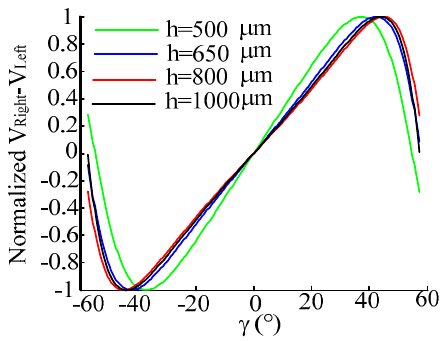
Figure 12. Normalized characteristic curve of V Right − V Left when changing γ . ( h is 500 μ m, 650 μ m, 800 μ m, 1000 μ m, respectively, and keeping p = 0 μ m and α = 20° constant).